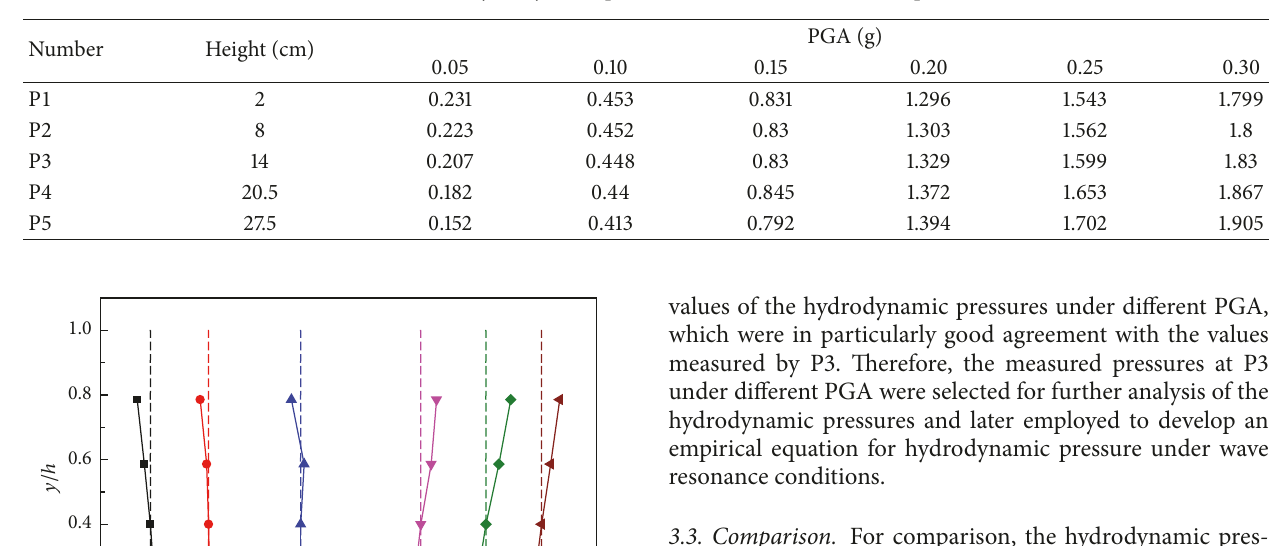
Figure 9: Hydrodynamic pressure variations at P1 due to EQ2. Table 2: Maximum values of the hydrodynamic pressure due to the Mexicali earthquake waveform (EQ2).